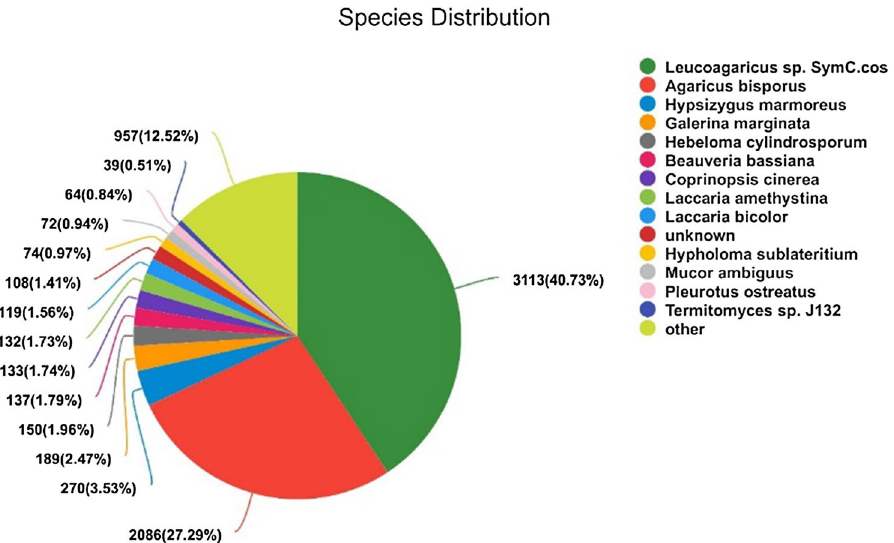
Figure 2. Homology (BLASTx matches) between C. comatus unigenes and unigenes of other species in the GenBank non-redundant (Nr) protein database. The first value indicates the number of matches, and the value in parenthesis indicates the percentage of all matches represented by the indicated species. Each piece of fan indicates the number of top BLAST matches against the Genbank non-redundant (Nr) protein database for various